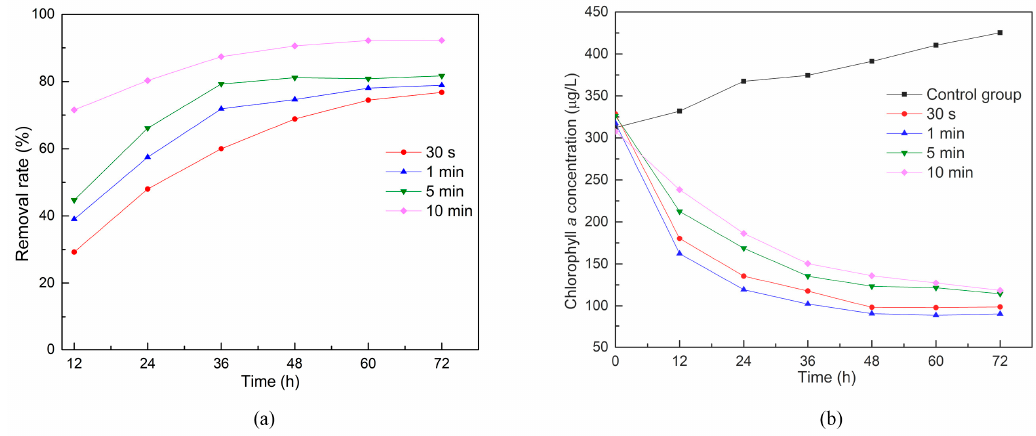
Figure 4. ( a ) Algae removal rate and ( b ) concentration of chlorophyll a after ultrasonic radiation treatment of di ff erent treatment of different durations.